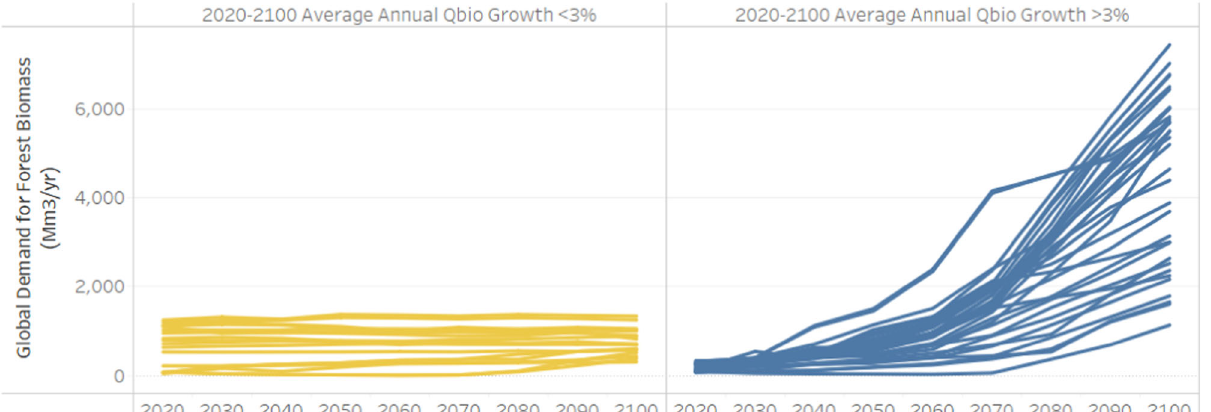
Fig. 1 Fifty-one forest biomass demand pathways in million m 3 (Mm 3 ) per year broken out by 2020 – 2100 average demand growth rate (2020 –